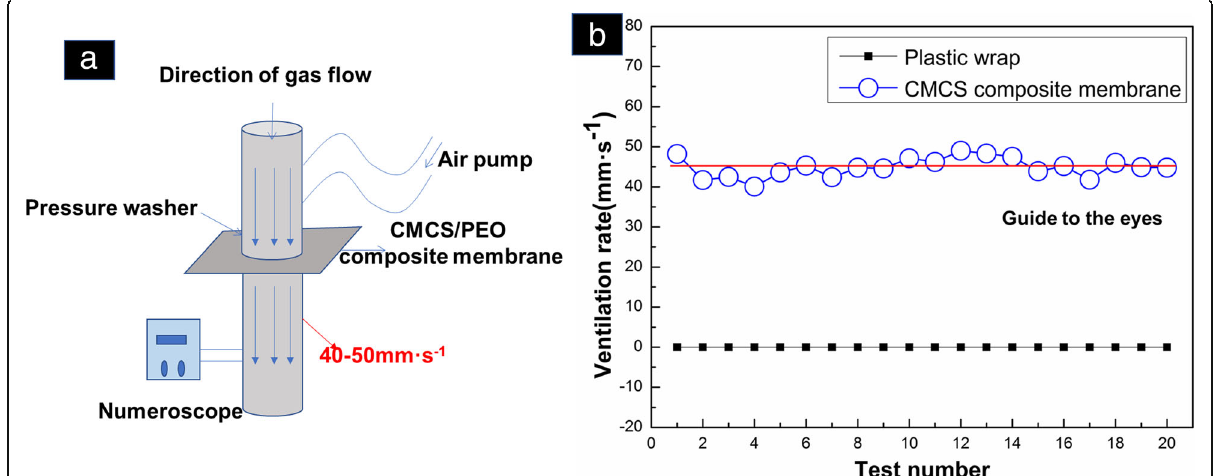
Fig. 5 The air permeability of a schematic diagram of experimental set-up and b the air permeability PEO/CMCS nanofiber membrane with the ratio of 1:12. The data focuses on 45 mm s − 1 . The red line is a guide to the